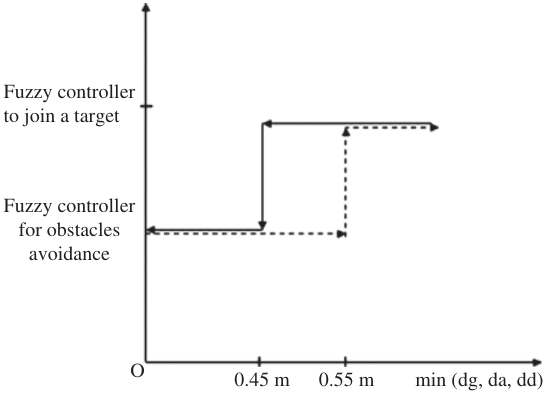
Figure 10: Hysteresis Switch.